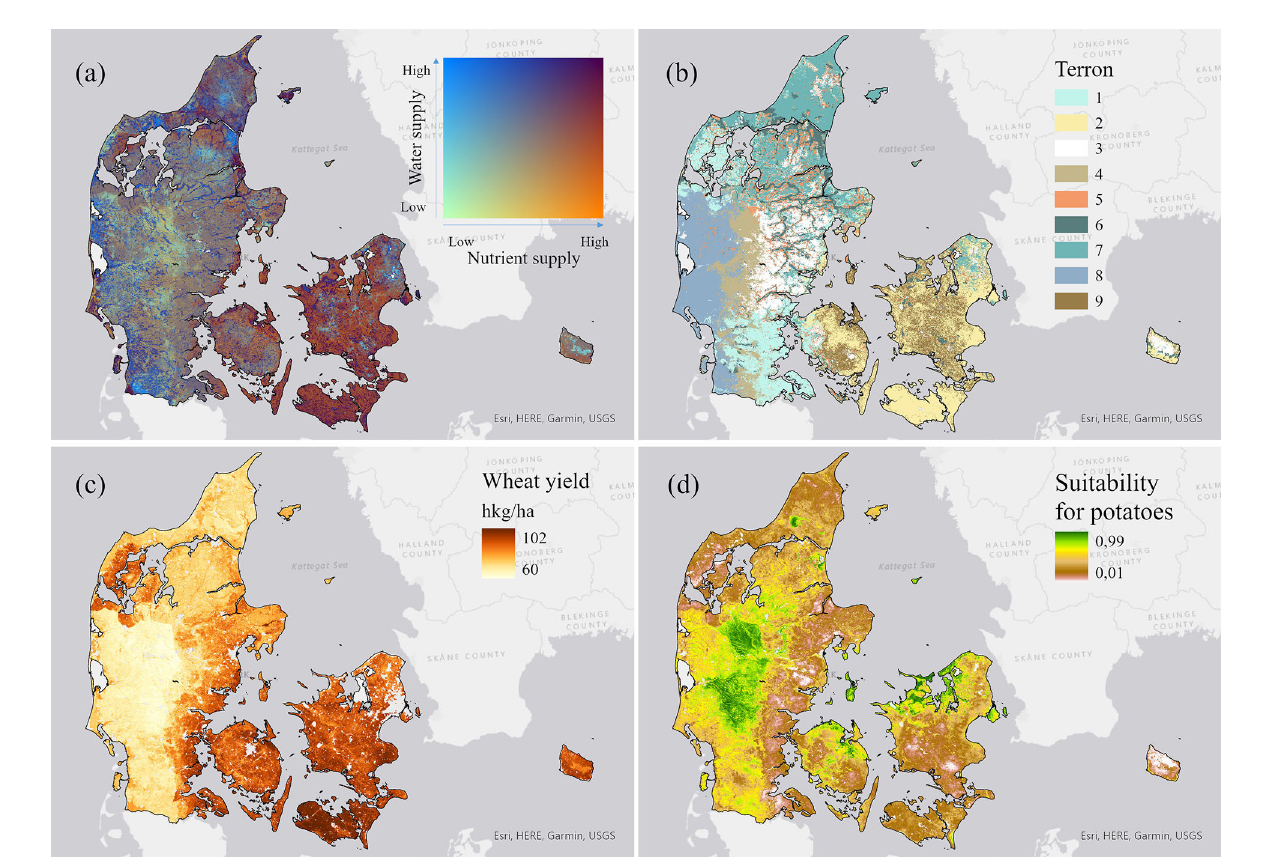
FIGURE 7 Examples of maps related to agricultural production in Denmark: (A) spatial distribution of water and nutrient supply in soils, (B) terron classes, (C) wheat yield, and (D) land suitability for